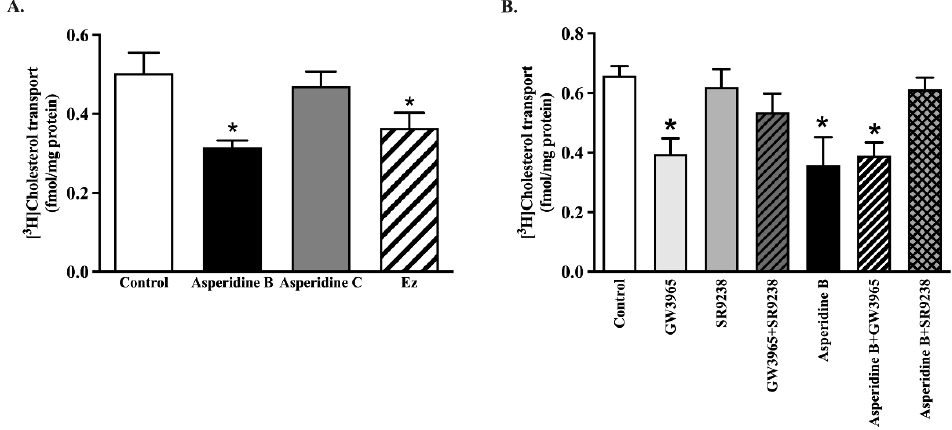
Figure 5. Effect of asperidines B and C, ezetimibe, LXR α activator (GW3965), and LXR α inhibitor (SR9238) on [ 3 H]-cholesterol transport using ex vivo rat jejunal loops: ( A ) 100 µM asperidine B, asperidine C, or ezetimibe was co-injected in rat jejunal loops and incubated for 30 min; ( B ) 100 µM asperidine B, 1 µM LXR α activator (GW3965), 10 µM LXR α inhibitor (SR9238), a combination of GW3965 with either SR9238 or asperidine B, and a combination of SR9238 with asperidine B were incubated in a buffer containing [ 3 H]-cholesterol mixed micelle for 30 min. The radioactivity accumulated in intestinal epithelium was then measured and expressed as fmol/mg protein. Values are mean ± SEM ( n = 6), * p < 0.05 vs. control.